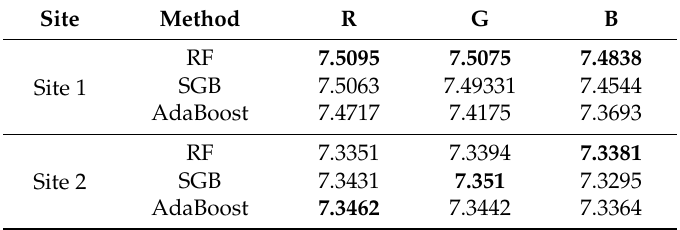
Table 8. Comparison of entropy of fused KOMPSAT-5 image through RF, SGB, and